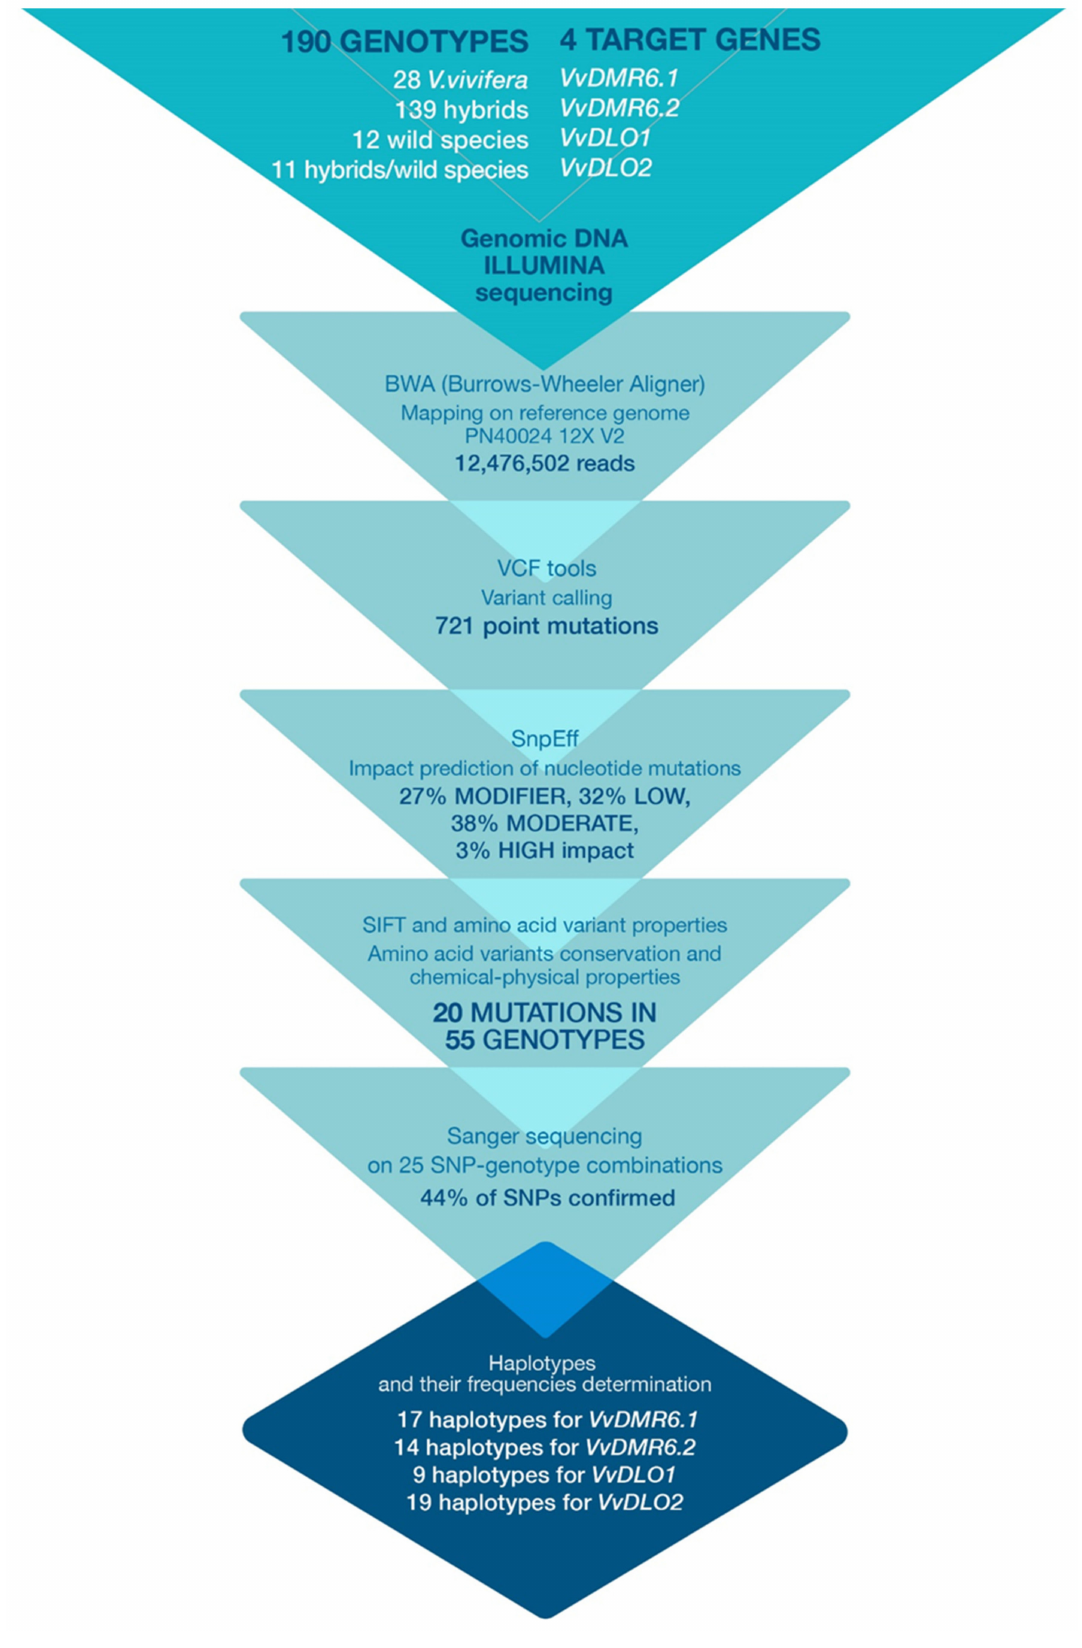
Figure 1. Flow chart of the analysis—tools and criteria—of sequencing data and results obtained downstream of each